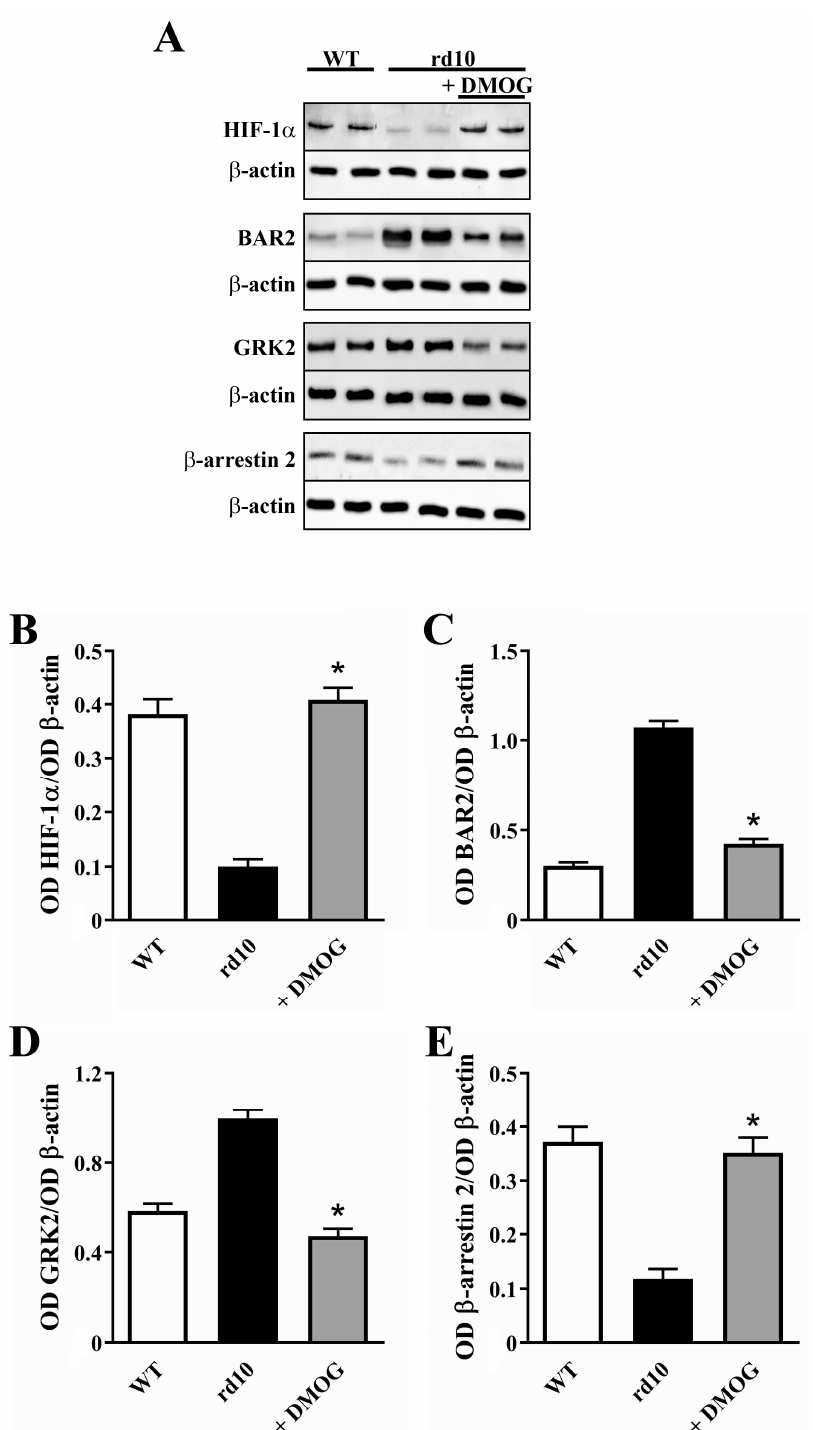
Figure 5. Expression of hypoxia-inducible factor (HIF)-1 α , BAR2, GRK2 and β -arrestin 2 in the retina of untreated WT and rd10 mice either untreated or treated with dimethyloxalylglycine (DMOG). ( A ) Representative Western blots from retinal homogenates. ( B – E ) Densitometric analysis of HIF-1 α ( B ), BAR2 ( C ), GRK2 ( D ) and β -arrestin 2 ( E ) levels. In rd10 mice, DMOG increased HIF-1 α and β -arrestin 2 levels, while it reduced BAR2 and GRK2 levels ( n = 5 samples per group, each containing 2 retinas from independent mice). * p < 0.001 versus untreated rd10 (one-way ANOVA followed by the Tukey post-hoc test).